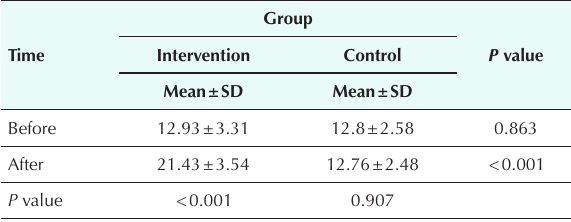
Table 3. Between- and within-group comparisons respecting the mean score of self-efficacy